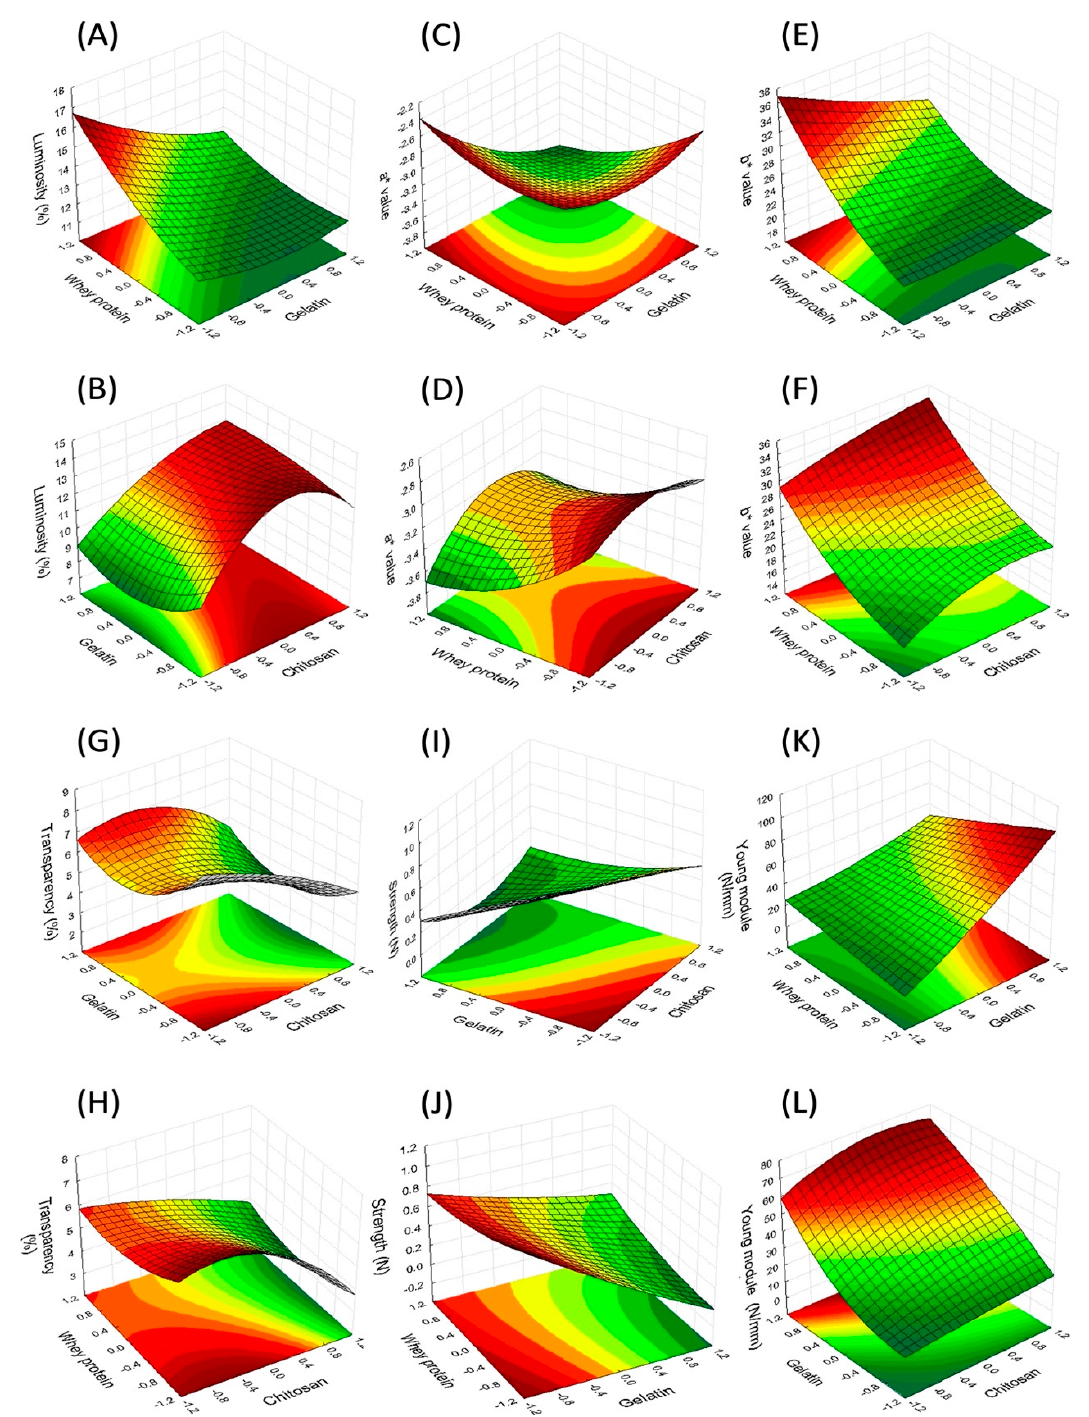
Figure 2 . Response surface plots showing the interaction effects of process variables on T: thickness ( A , B ), MC: moisture content ( C , D ), WAC: water absorption capacity ( E , F ), S: solubility ( G , H ) and WVP: water vapor permeability ( I , J ). − 1.0 minimum level of component; 1.0, maximum level of component; 0, mid-level of component. For each surface plot, the level of the third factor is held at its central value. The regions with the dark red color represent the dominant working conditions, ensuring the maximum values for the variables evaluated.